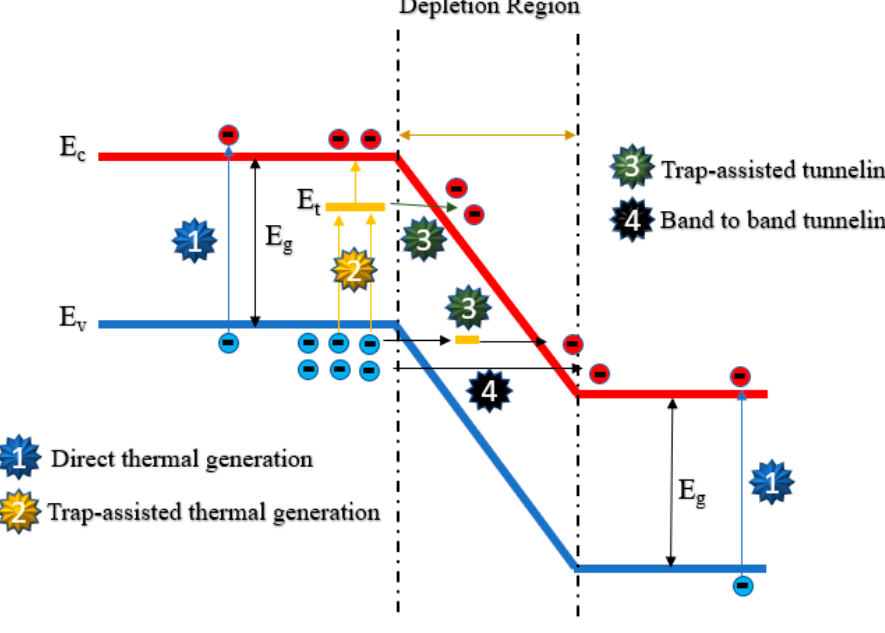
Figure 6. Four major mechanisms of DCR in